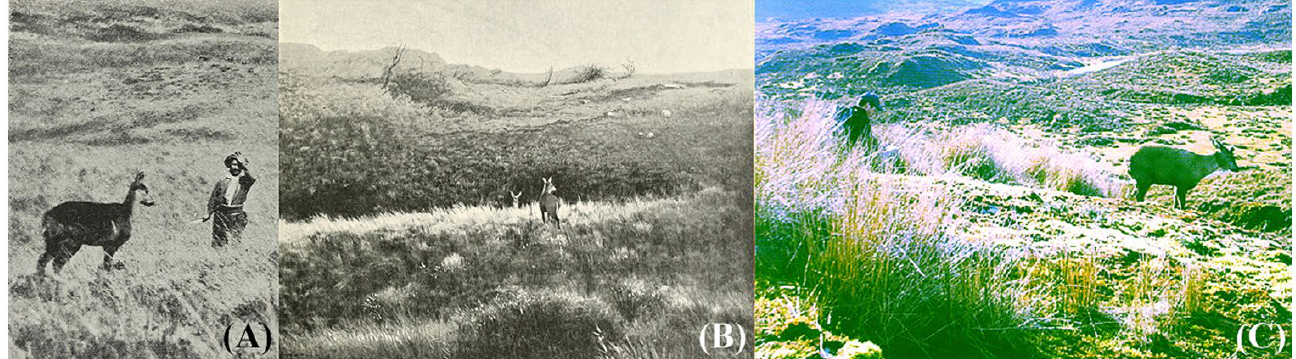
Figure 1. Huemul are well-known for their use of steppe grassland and lack of fear of humans. ( A ) gaucho putting to death a huemul using a knife, photographed by Onelli in 1904, see Supplementary File S1, ( B ) huemul walking away after having sniffed the leg of Prichard in 1902, see Supplementary File S1, ( C ) a more recent close encounter near Cochrane, Chile.